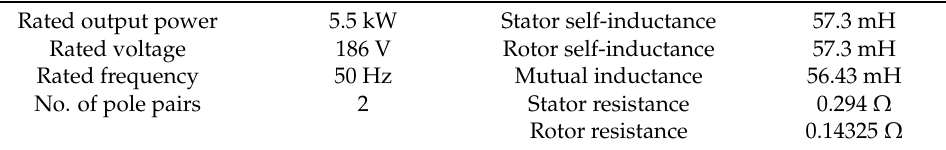
Table A1. The rated values and parameters of the